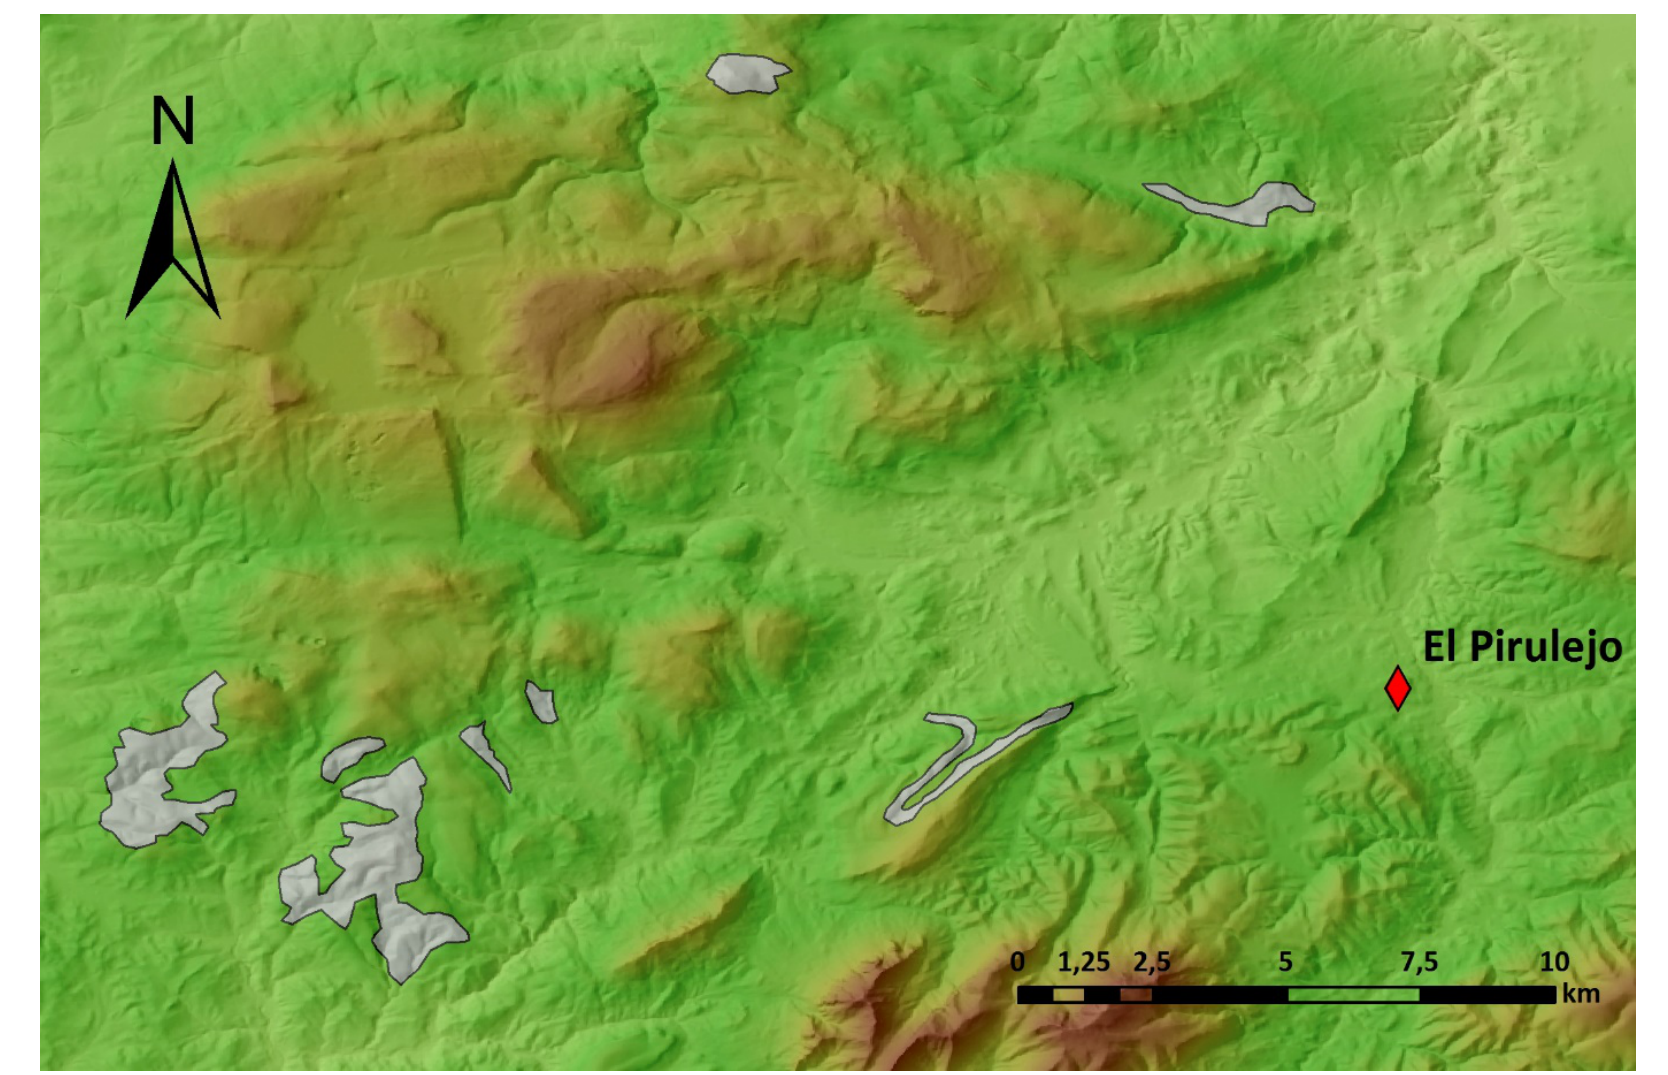
Figure 4. Maps of the Veleta Formation. Prospected areas. (Compiled by the